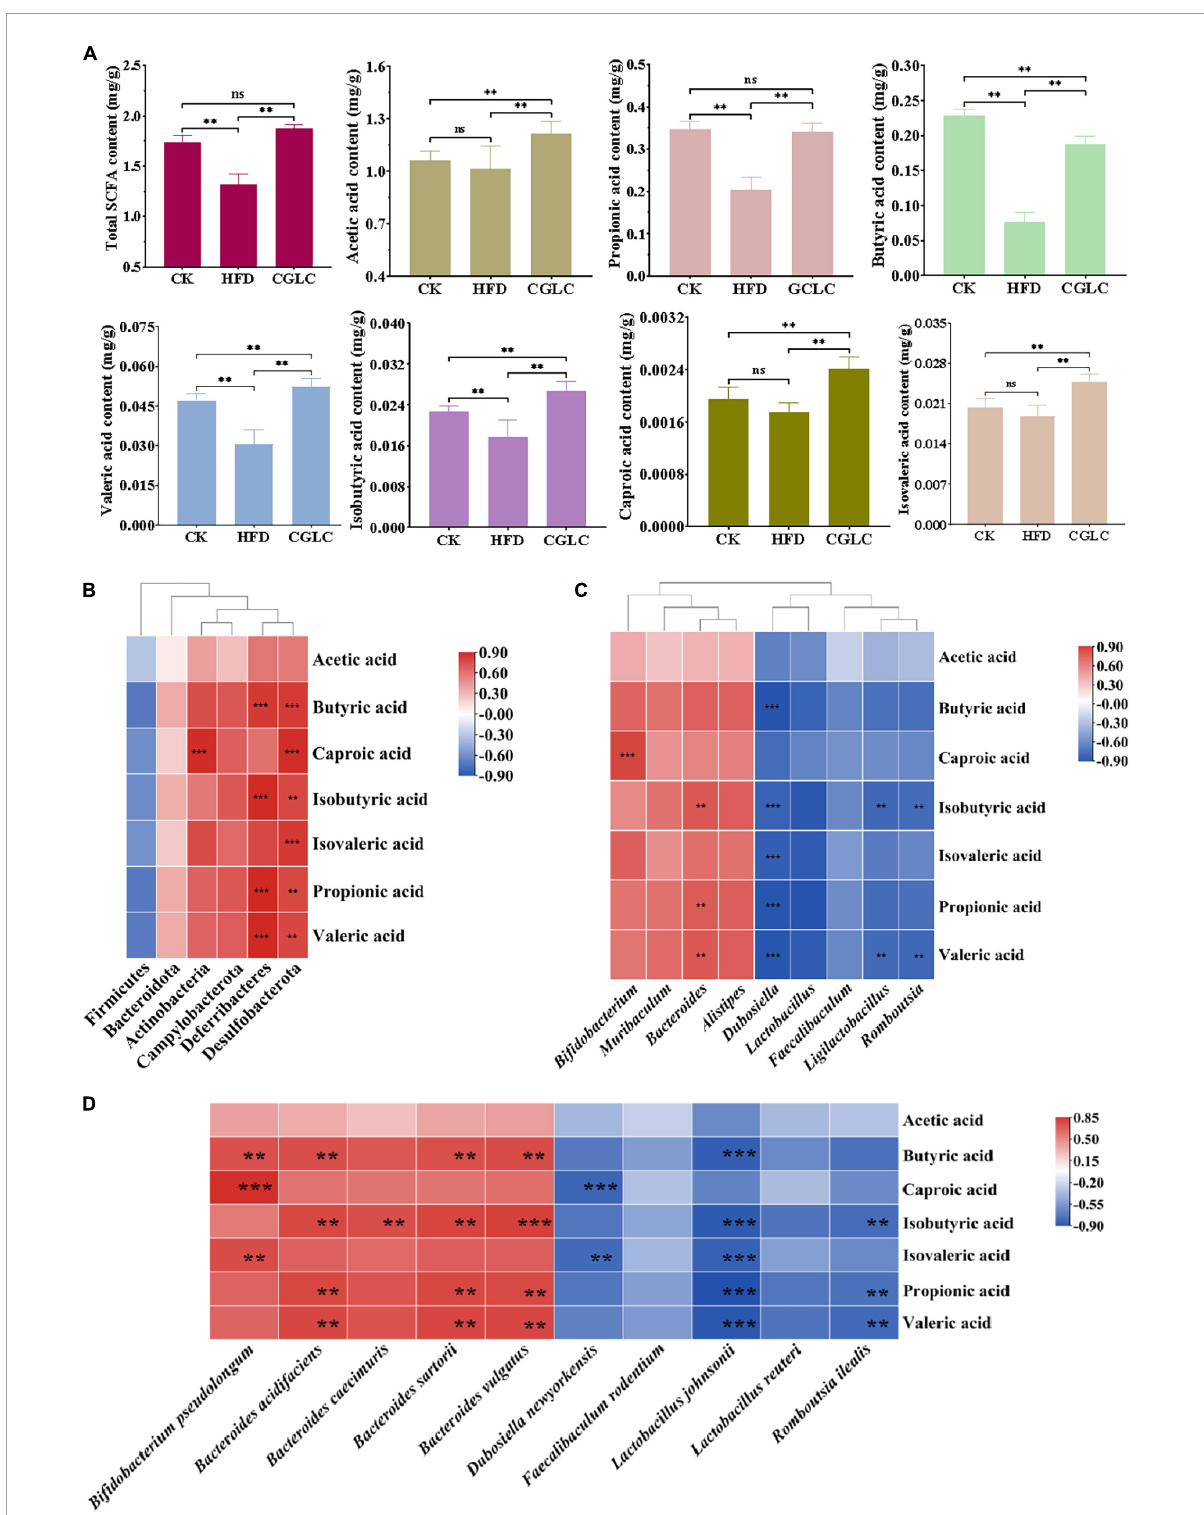
FIGURE5 Cordyceps guangdongensis lipid-lowering compound formula increased the contents of SCFAs in HFD mice (A) . Association analysis between the abundance of gut microbiota at the phylum level and SCFAs (B) . Association analysis between the abundance of gut microbiota at the genus level and SCFAs (C) . Association analysis between the abundance of gut microbiota at the species level and SCFAs (D) . ns, no significant difference; ∗∗ and ∗∗∗ , significant correlation ( P < 0.01 and P <